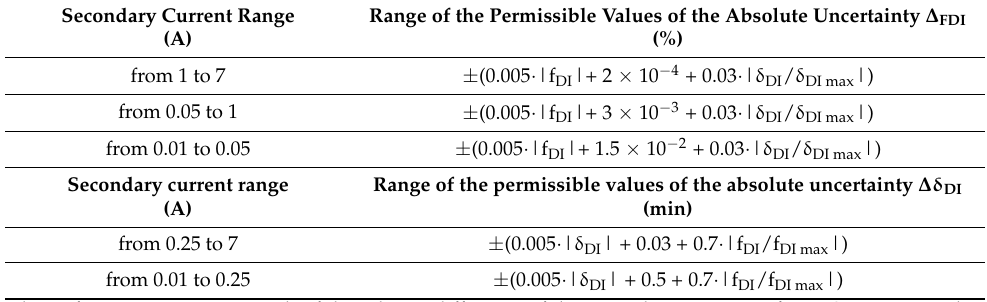
Table 2. The accuracy data of the CA507 comparator based on the user manual.